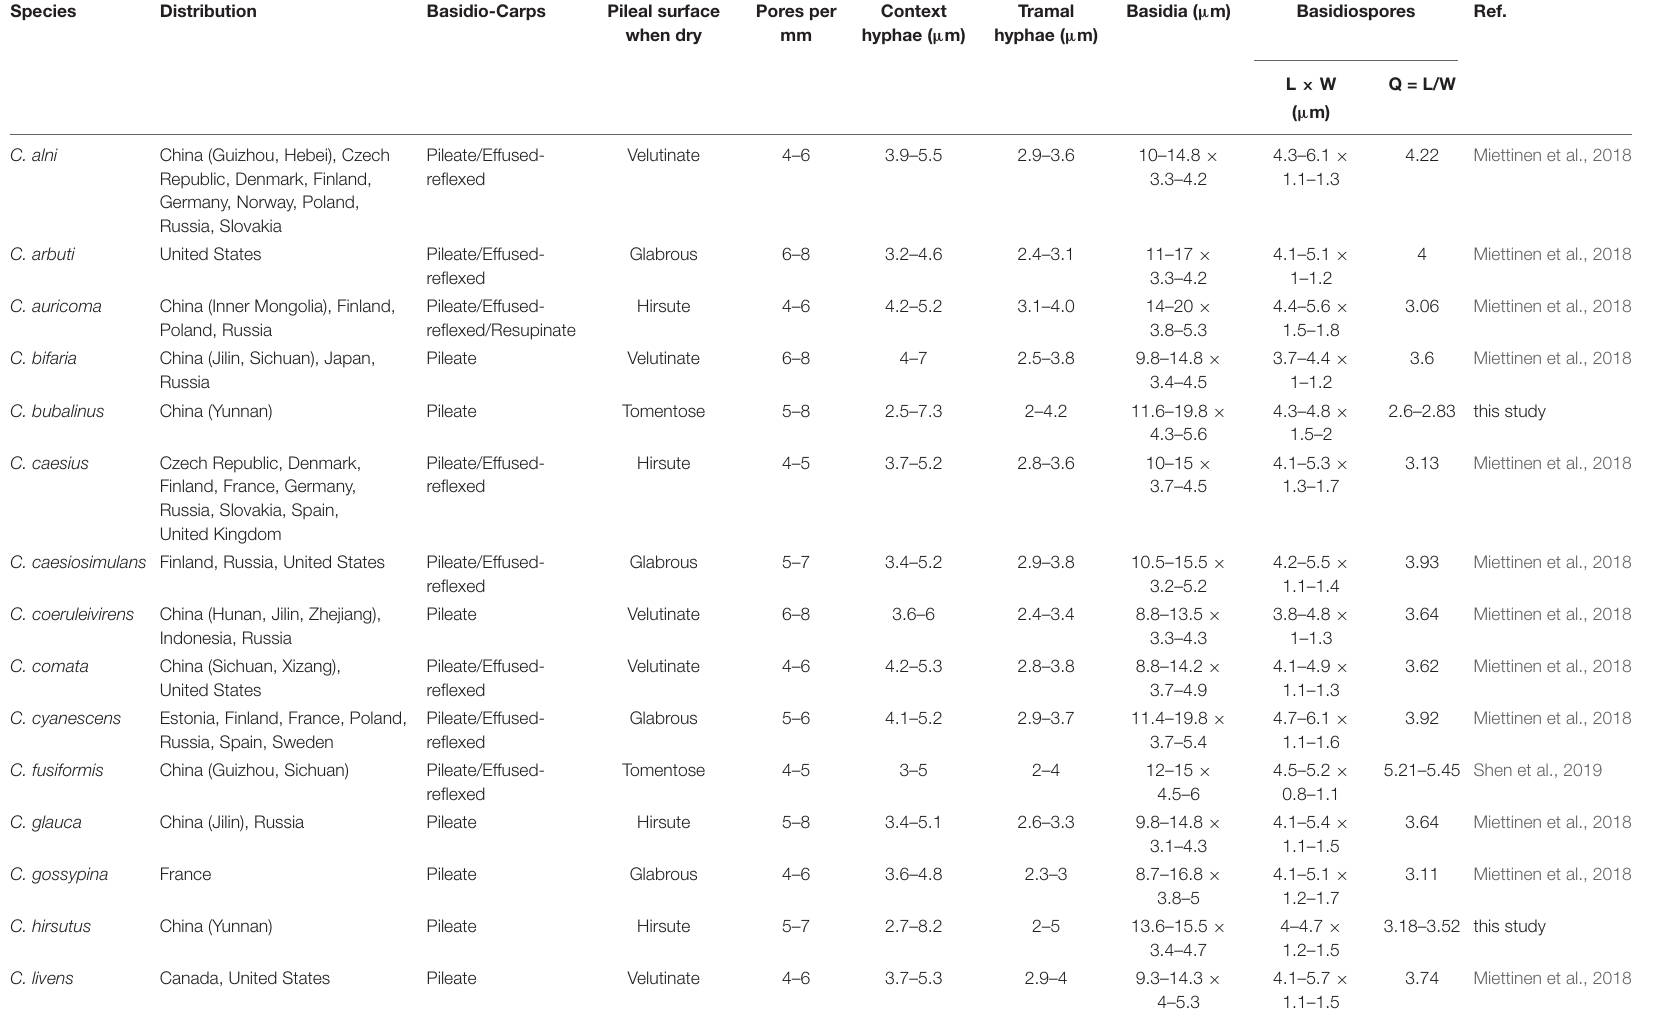
TABLE 2 | Comparisons of the main morphological characters of species in Cyanosporus